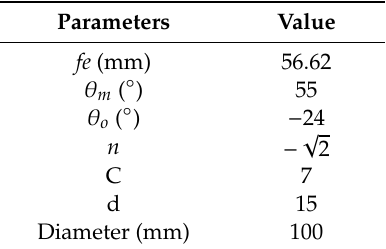
Figure 10. Abbe’s sine shaped lens. Table 4. Lens parameters.